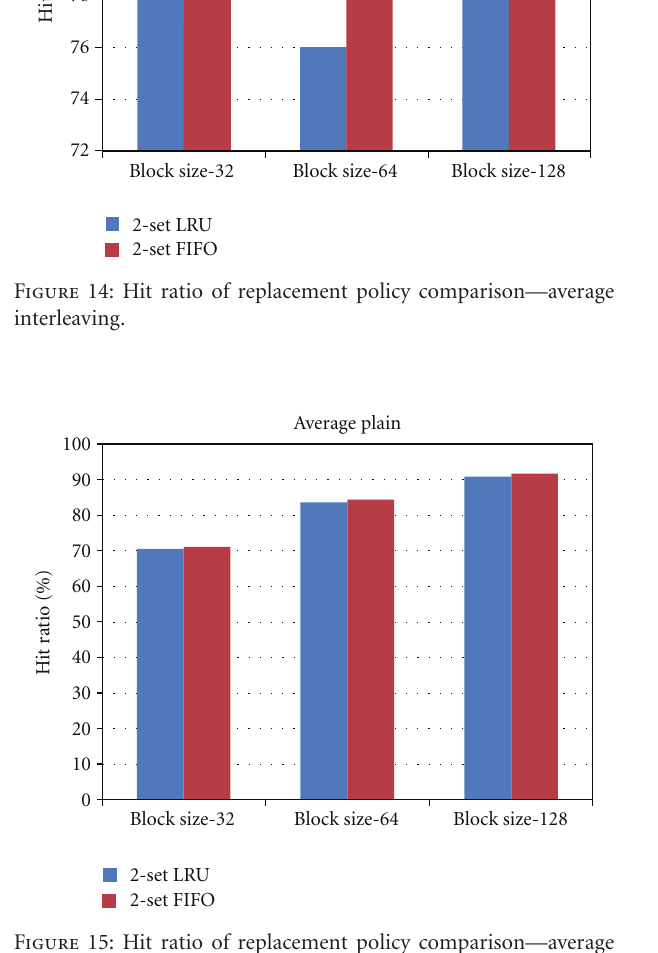
Figure 15: Hit ratio of replacement policy comparison—average